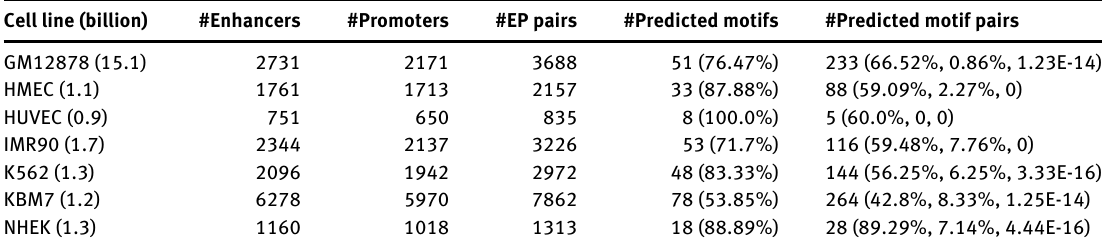
Table 1: The predicted motif pairs in seven cell